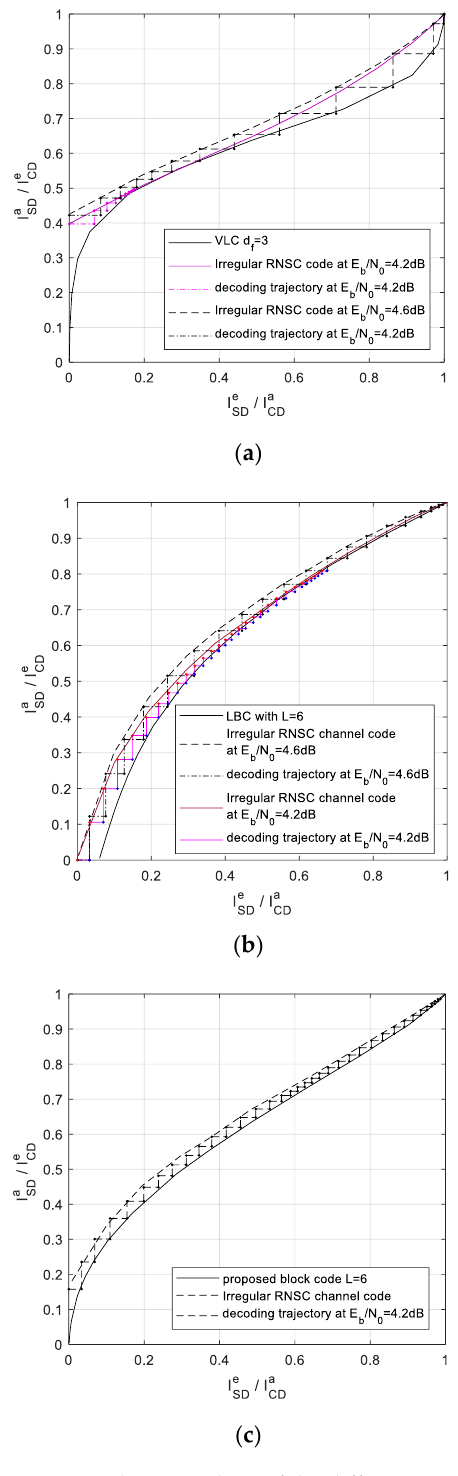
Figure 6. The EXIT chart of the different JSCC schemes using Irregular RNSC codes. ( a ) The EXIT chart of the VLC-IrRNSC scheme. ( b ) The EXIT chart of the LBC-IrRNSC scheme with L = 6. ( c ) The EXIT chart of the proposed scheme with L = 6. Table 5. Convergence performance of different source channel coding schemes.